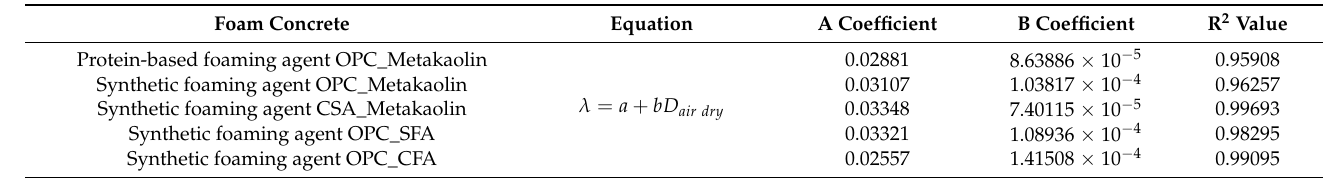
Table 7. Coefficients for the linear fit—thermal conductivity ( λ